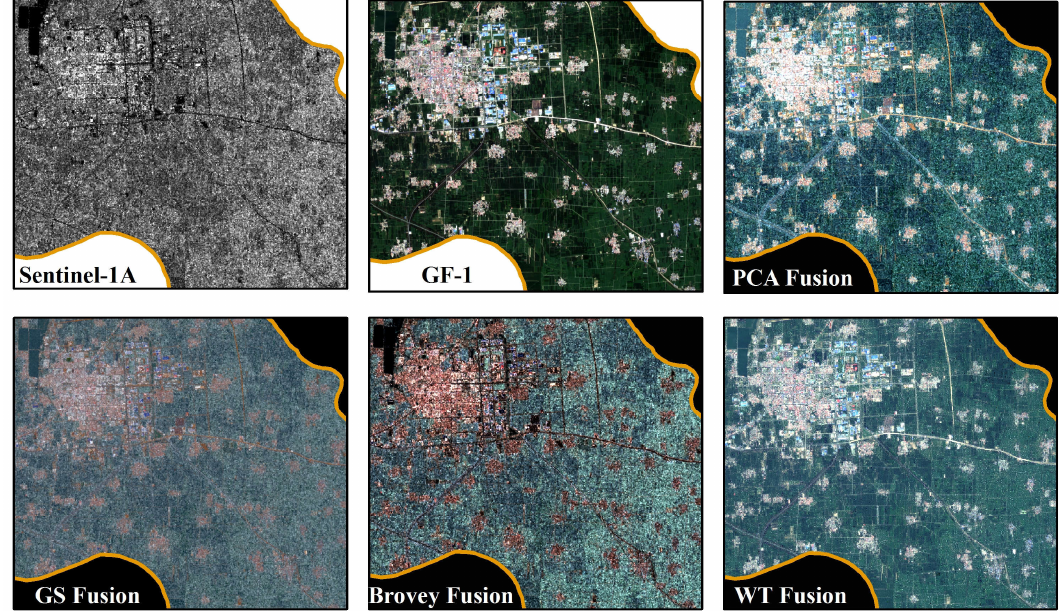
Figure 3. The comparison of fusion images with different methods (displayed in partial study area) Image